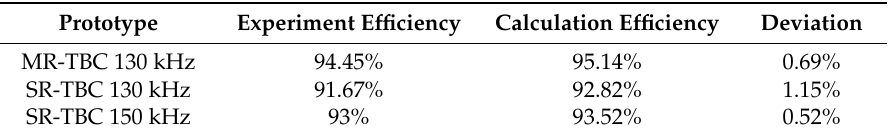
Figure 16 . Experimental results of MR-TP-BDC and SR-TBC under 500 W. ( a ) MR-TBC of 130 kHz; ( b ) SR-TBC of 130 kHz; ( c ) SR-TBC of 150 kHz. Table 4. Efficiency comparison between MR-TBC and SR-TBC in 500 W.